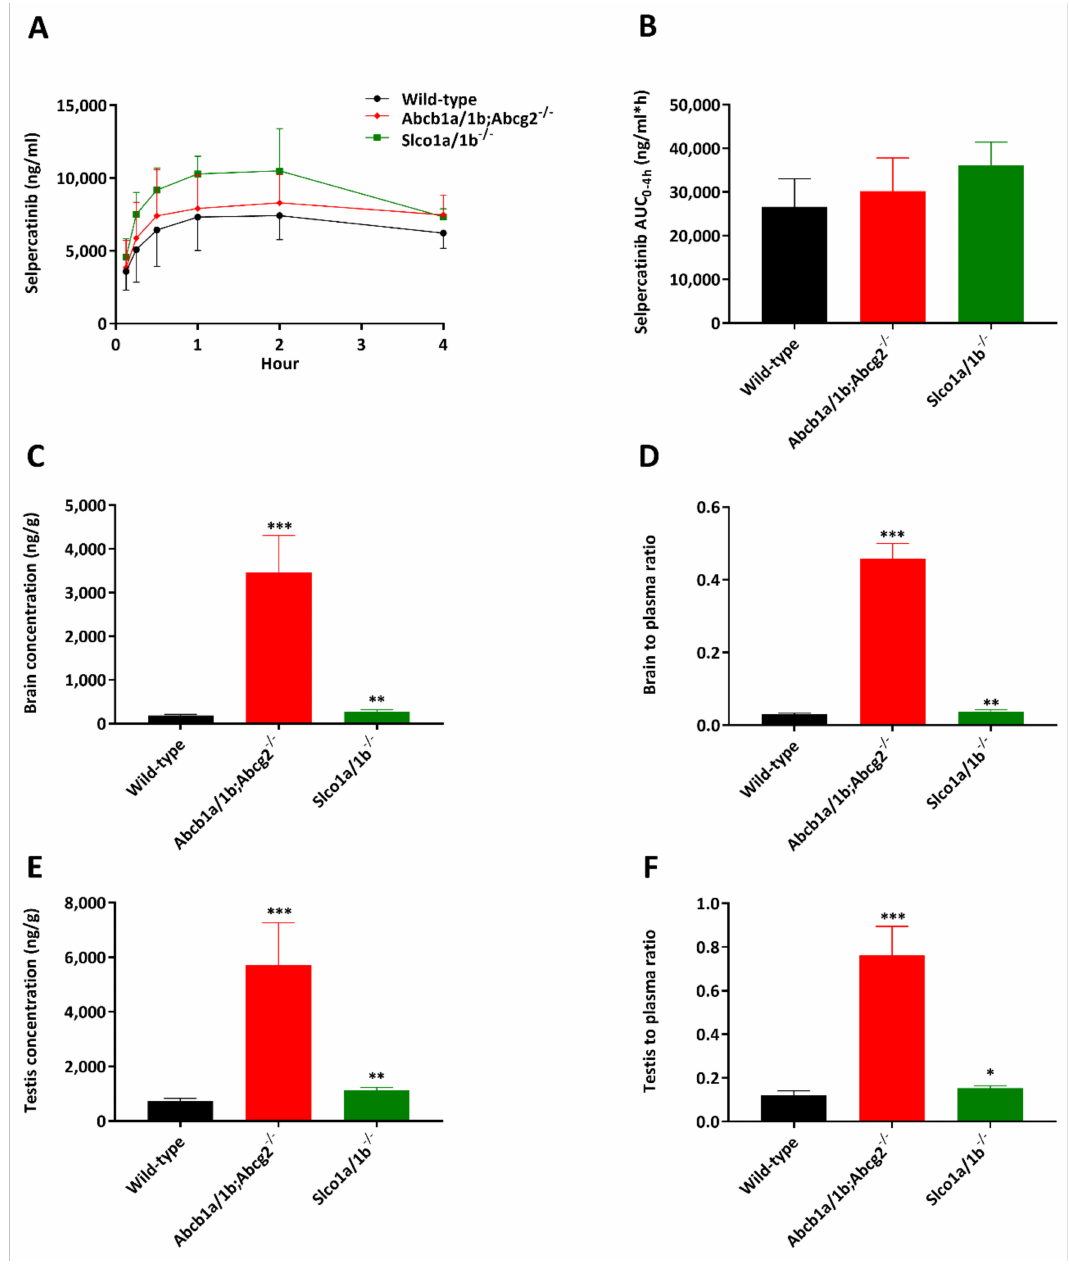
Figure 2. Plasma concentration–time curves ( A ), plasma AUC 0–4h ( B ), brain concentration ( C ), brain-to-plasma ratio ( D ), testis concentration ( E ) and testis-to-plasma ratio ( F ) of selpercatinib in male wild-type, Abcb1a/1b; Abcg2 -/- and Slco1a/1b -/- mice over 4 h after oral administration of 10 mg/kg selpercatinib. Data are given as mean ± S.D. (n = 6–7). Statistical analysis was applied after log-transformation of linear data. *, p < 0.05; **, p < 0.01; ***, p < 0.001 compared to wild-type mice. Statistical analysis was applied after log-transformation of linear